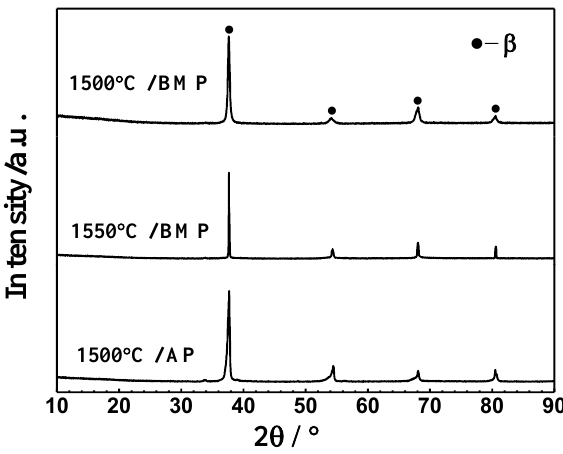
Figure 5. XRD patterns of Ti-28Nb-35.4Zr alloy prepared with different temperatures and powders.